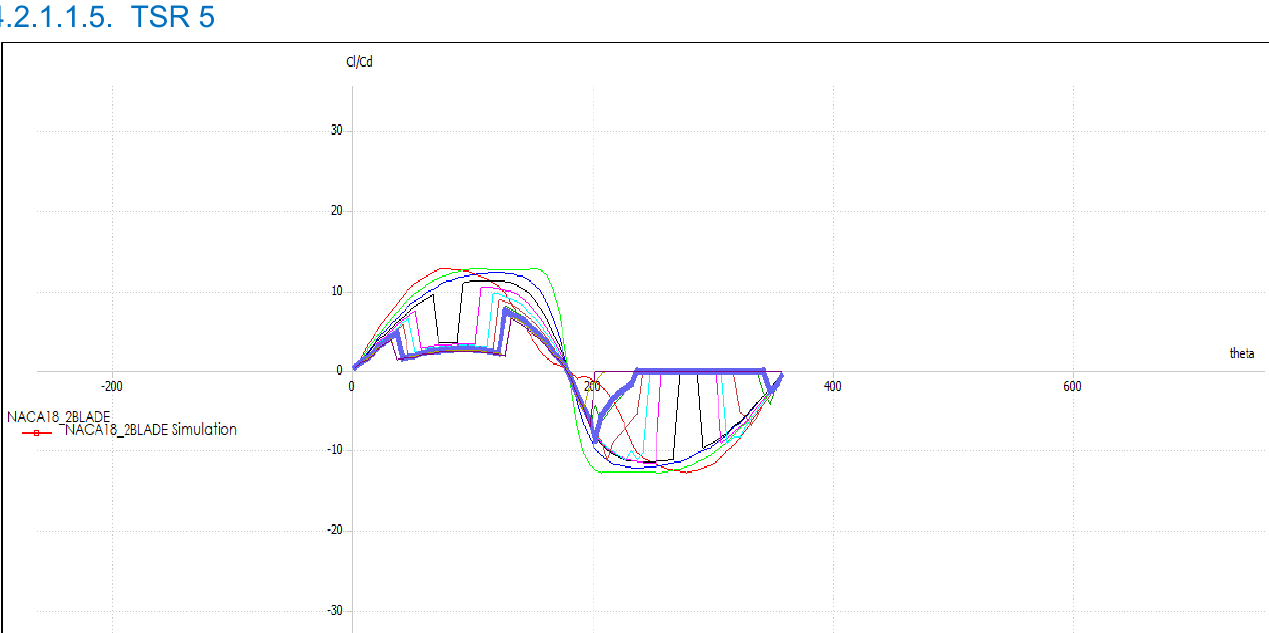
Figure 16. Cl/Cd vs theta plot of top-section for TSR 5